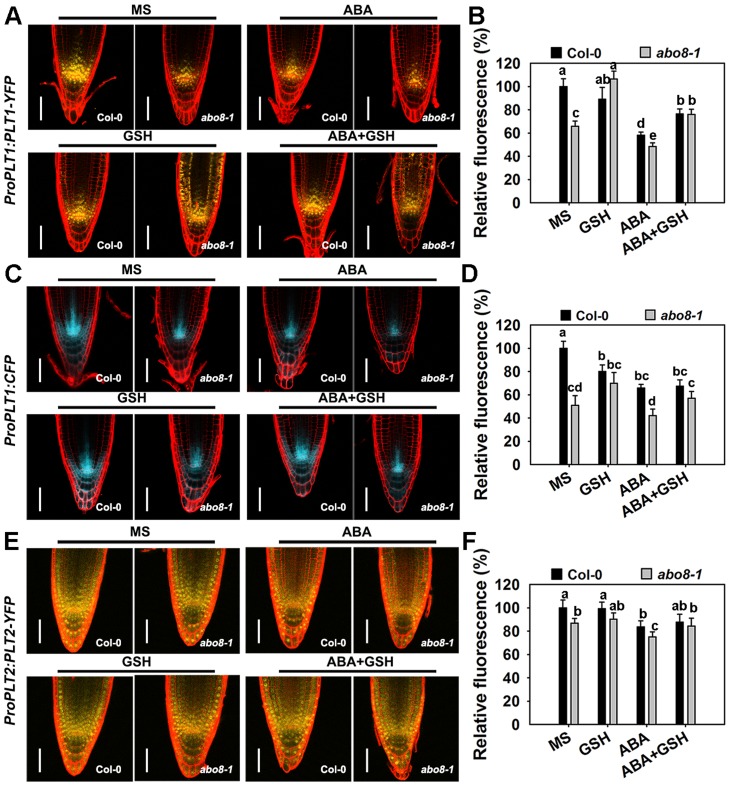
The abo8 mutation affects the expression of PLT1 and PLT2.A. The expression of ProPLT1:PLT1-YFP on MS medium or MS medium supplemented with ABA, GSH, or ABA plus GSH. Bars = 50 µm. B. The fluorescence of PLT1-YFP in (A). Fluorescence is expressed relative to that of the wild type in MS without supplement. Three independent experiments were done with similar results, each with three replicates. In each replicate, 8–15 roots were measured from one plate. Values are means ±SE from one experiment. Means with different letters are significantly different at P<0.01, except for c and d, d and e, at P<0.05. C. The expression of ProPLT1:CFP on MS medium or MS medium supplemented with ABA, GSH, or ABA plus GSH. Bars = 50 µm. D. The relative fluorescence of ProPLT1:CFP in (E). Fluorescence is expressed relative to that of the wild type in MS without supplement. Three independent experiments were done with similar results, each with three replicates. In each replicate, 8–15 roots were measured from one plate. Values are means ±SE from one experiment. Means with different letters are significantly different at P<0.01, except for a and b, c and d, at P<0.05. E. The expression of ProPLT2:PLT2-YFP on MS medium or MS medium supplemented with ABA, GSH, or ABA plus GSH. Bars = 50 µm. F. The relative fluorescence of PLT2-YFP in (C). Fluorescence is expressed relative to that of the wild type in MS without supplement. Three independent experiments were done with similar results, each with three replicates. In each replicate, 8–15 roots were measured from one plate. Values are means ±SE from one experiment. Means with different letters are significantly different at P<0.05.